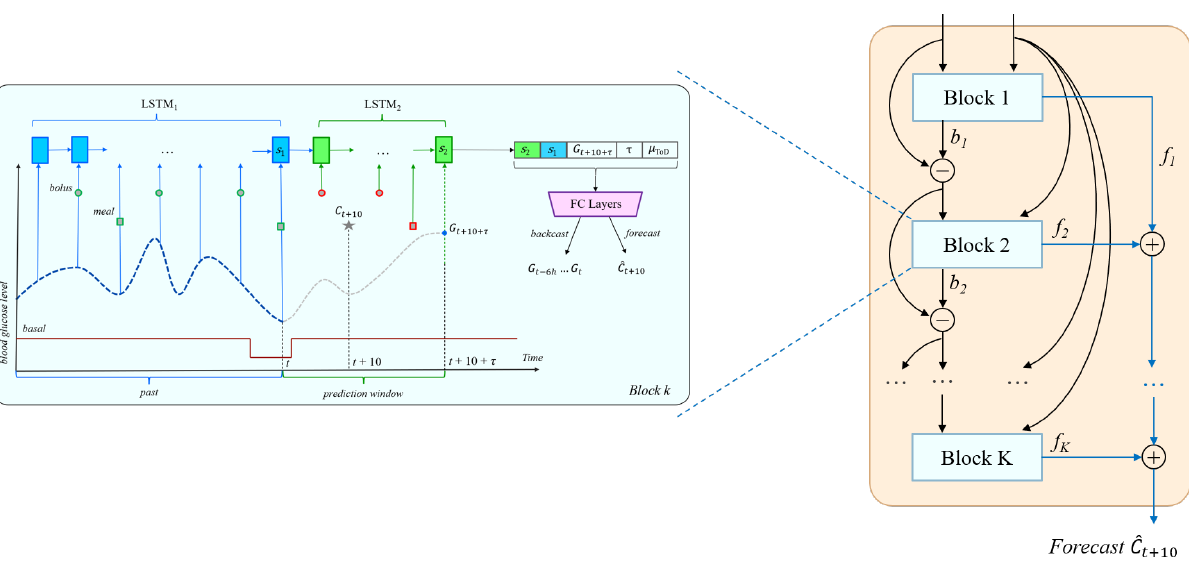
Figure 3. The N-BEATS inspired deep residual architecture for carbohydrate recommendation. A similar architecture is used for bolus and bolus given carbs